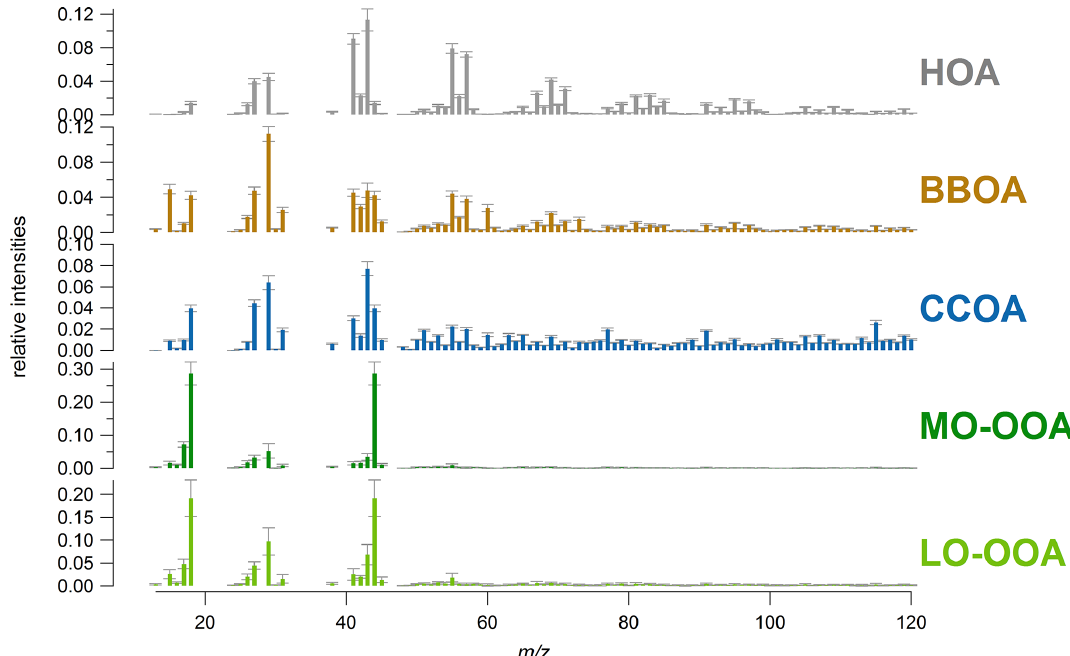
Figure 2. Mean factor profiles of the five factors. The profile variability is represented by the grey error bars (standard deviation).